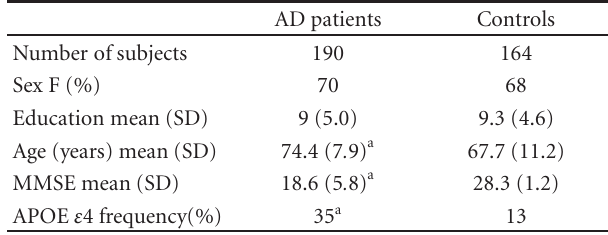
Table 2: Demographic characteristics of the investigated groups. Data are mean